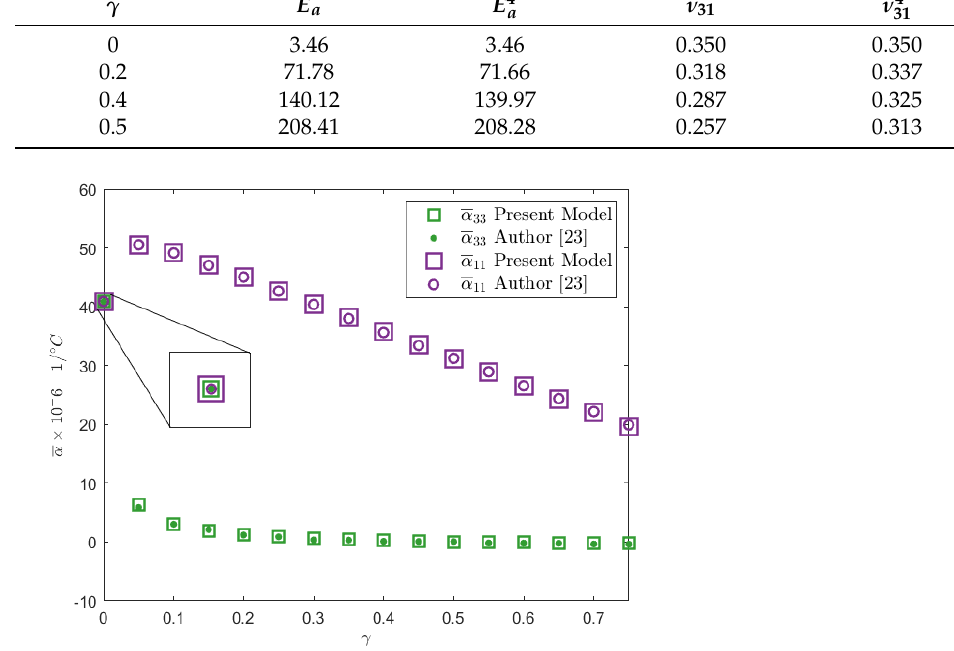
Figure 8. Effective thermal expansion coefficients for Graphite/Epoxy calculated using the linear FEM and those reported in ref. [23].